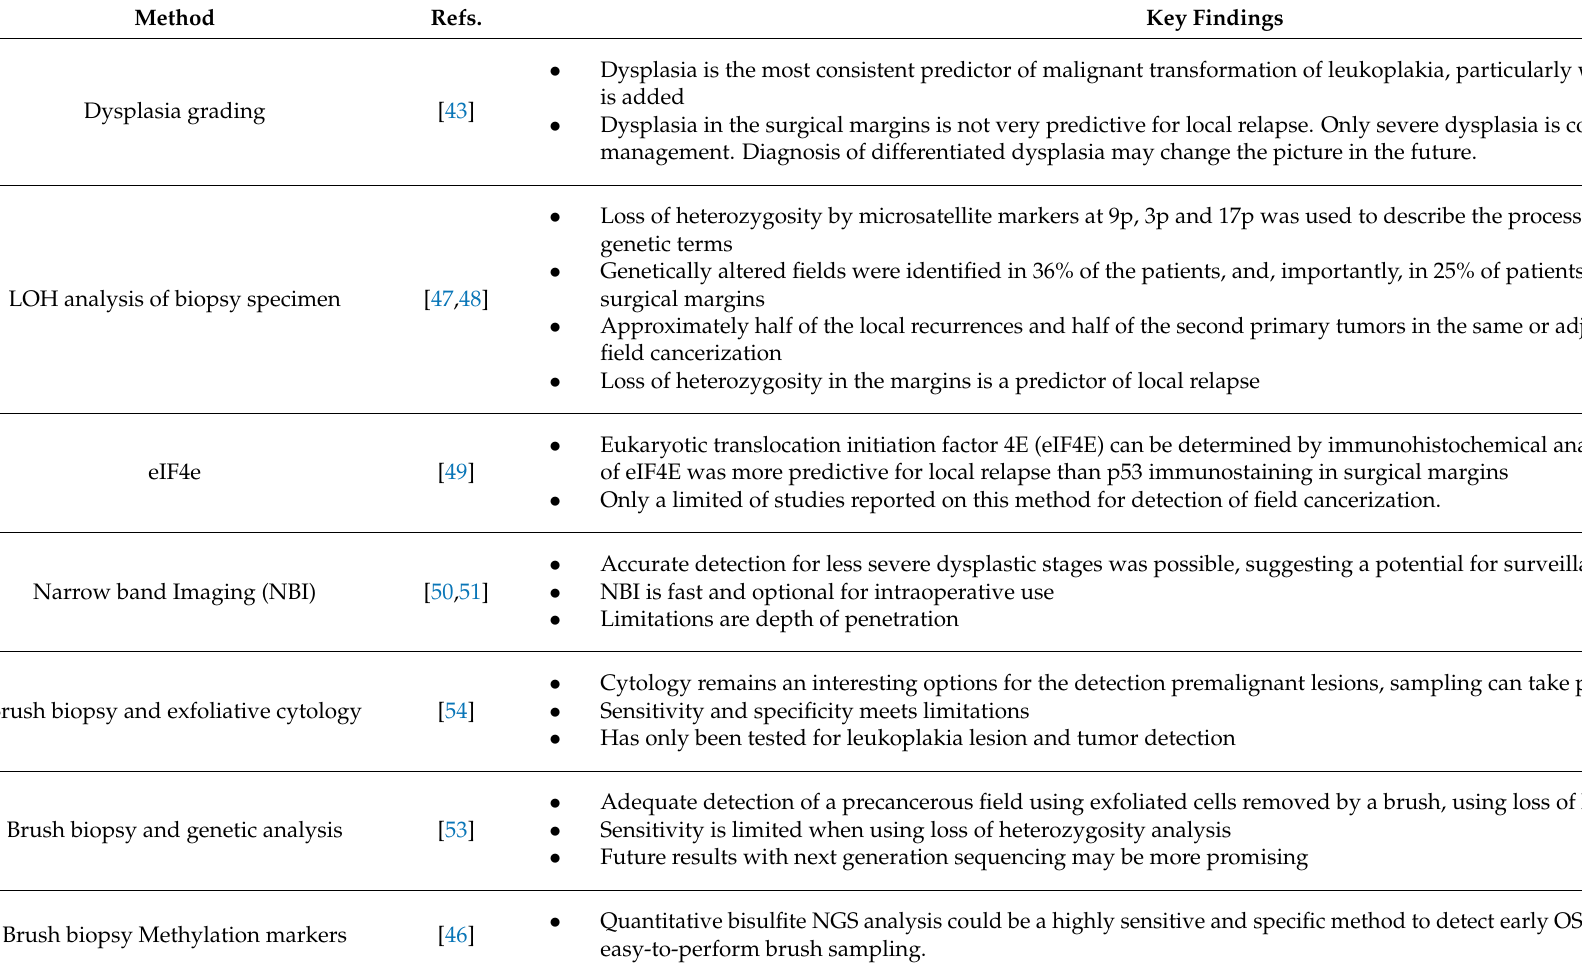
Table 2. Overview of a number of detection and visualization methods for field